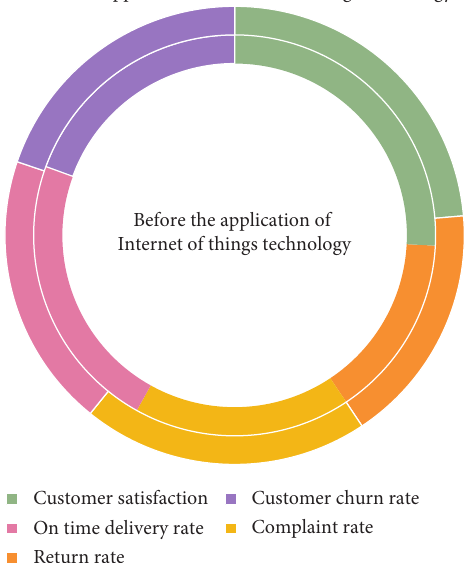
Figure 10: Competitiveness value of each subindex of the customer service index.